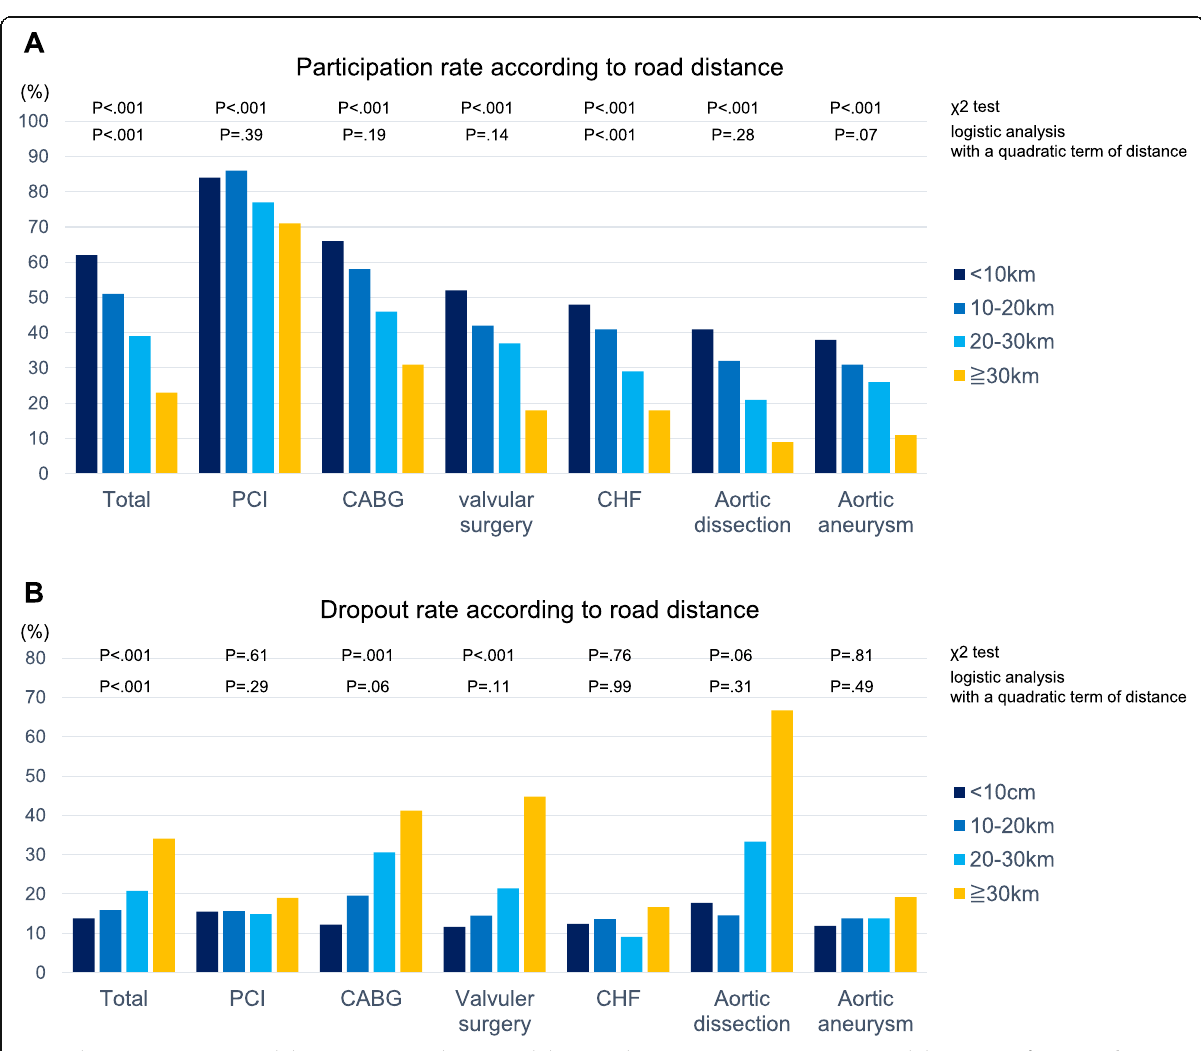
Fig. 4 The participation rate and dropout rate according to road distance. The participation rate in OCR ( a ) and dropout rate from OCR ( b ) according to the road distance from home to hospital in subgroups with cardiovascular diseases. The OCR participation rate and dropout rate according to road distance from patients ’ homes to the hospital (< 10 km, 10 – 20 km, 20 – 30 km, and ≧ 30 km) were compared using the χ 2 test to examine the participation rate and dropout rate as the distance increases by 10 km. The logistic analysis adjusted for confounding variables with a quadratic term of distance as a continuous variable was also performed. PCI, percutaneous coronary intervention; CABG, coronary artery bypass grafting; CHF, congestive heart